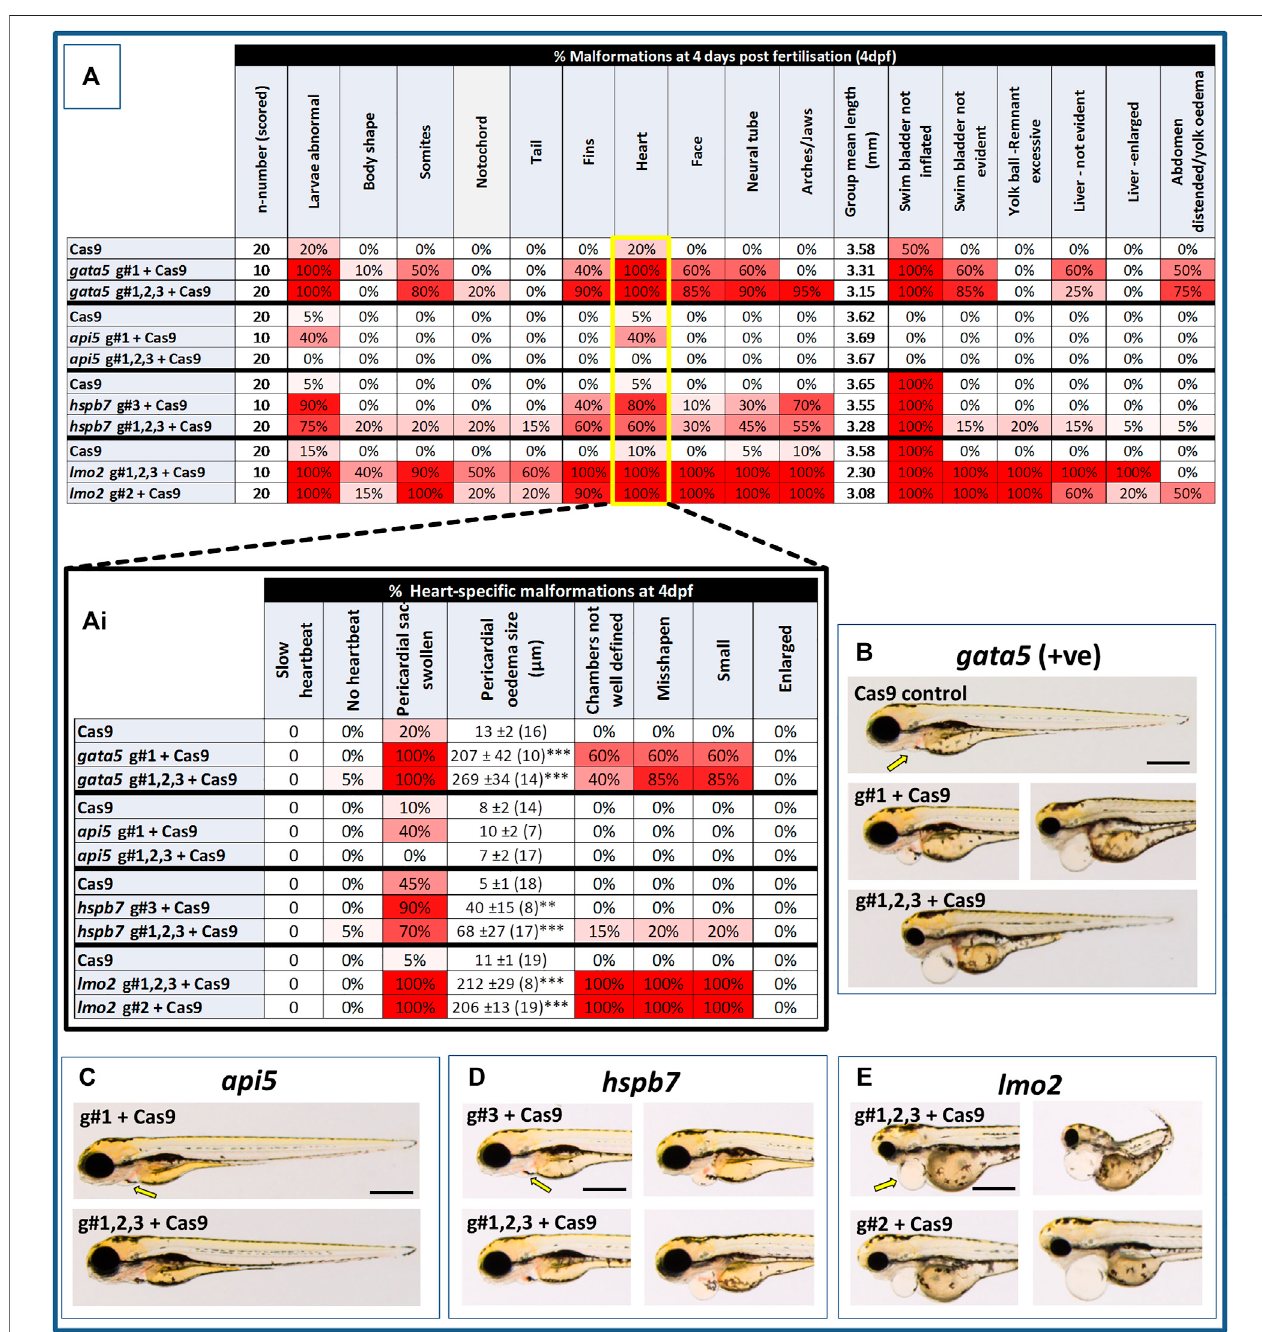
FIGURE3| Resultsofthemorphologicalanalysisof4dpf gata5 (positivecontrol), api5 , hspb7 and lmo2 zebra fi shcrispantsvs.theCas9-injectedcontrolanimals.Panel (A) : GeneralwholebodymorphologicalendpointsmeasuredfollowinginjectionofCas9alone,oraftermutationofeachofthegenesassessed.Dataareshownasthe%incidenceof abnormalities under each category, with shades from white (0%) through to red (100%) providing an indication of the proportion of animals exhibiting a malformation within that category. Note different n-numbers present as two runs were undertaken for the Cas9 control and the gRNA + Cas9-injected group showing the most robust phenotype fromrun1(for lmo2 g#2wasruntwiceduetoconcernsaboutexcessivemortalityintheg#1,2,3group).Theguidecombinationusedfortworunsineachcaseisshowninthelower paneloftheexampleimagesforeachgene. Ai :Expansionofheart-speci fi cendpointsshowingthefullrangescoredincludingestimatesofthesizeofpericardialoedema.Dataare shownasthemean,±SEMand(n=numberofmeasurespossible)foreachtreatment,Forthesedata,**signi fi esastatisticallysigni fi cantdifferencevs.theCas9controlat p < 0.01, and***at p < 0.001( t -testorMannWhitneyU-testsforthecombinedguideinjectedgroups,or1-wayANOVAandTukey ’ sHSDtestsorKruskal – WallisandDunn ’ stestsforthe singleguideinjectedgroups,inwhichrun1and2datawerecombined). (B) :examplelarvaefollowing gata5 mutationvs.theCas9-injectedcontrol.Theyellowarrowsindicatethe positionofthepericardialmembraneandtheextentofpericardialoedema,whichwasminimalinthecontrolsbutextensiveinmostcrispantanimals(twoexamplesareshownfor g#1-injectedanimalsastherewassomevariabilityintheseveritiesseen). (C – E) :examplesoflarvaefollowingknockoutofeachoftheothergenesassessed(notetheapparentlack of effect of api5 mutation on general morphology). The scale bar shown in the fi rst image of panels B – E represents 500 μ m.